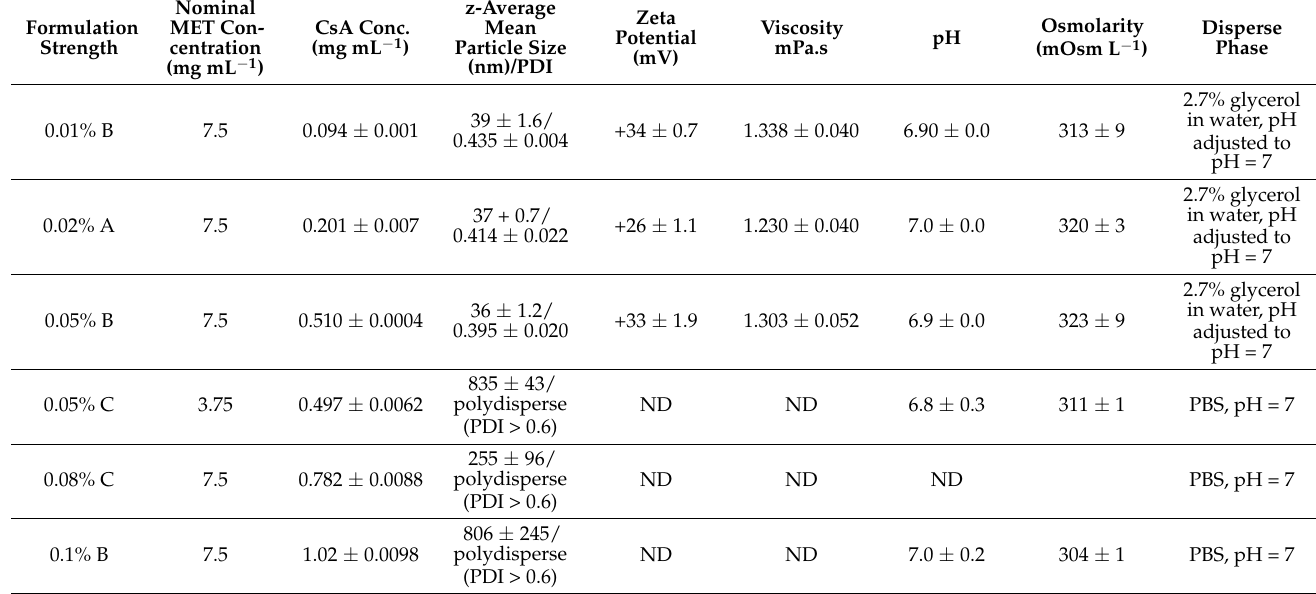
Table 2. NM133 Formulation Characteristics, mean ± s.d. from three independent